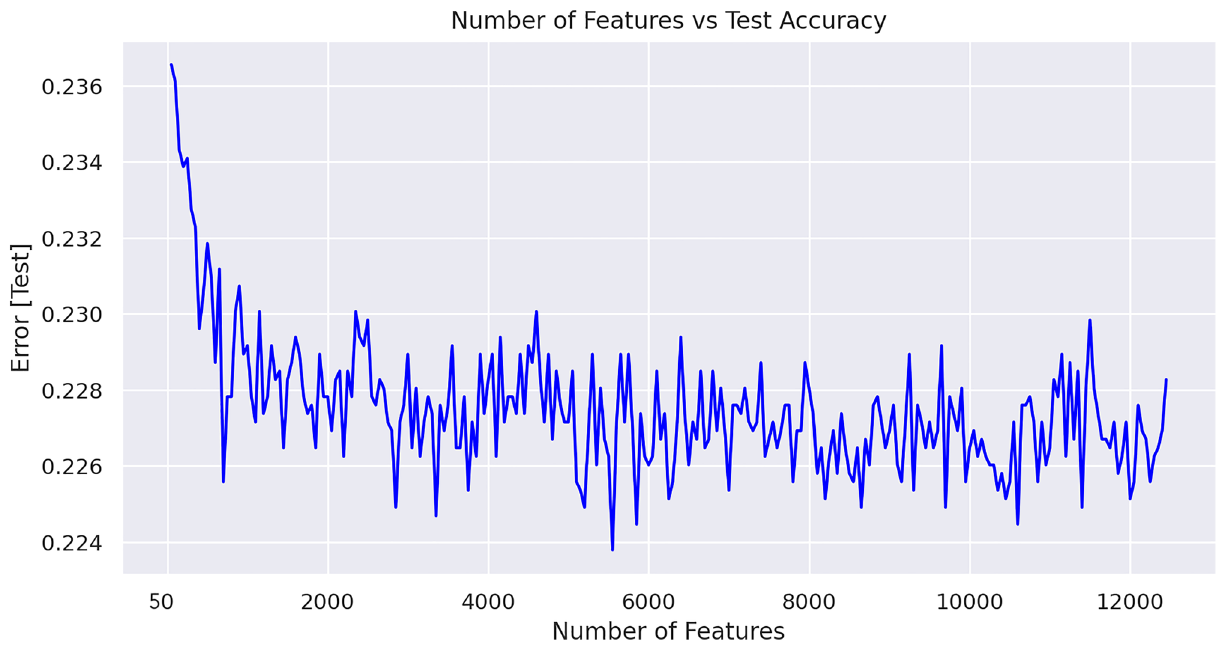
Figure 4. Number of features used for model training vs test error for xgBoost model trained on Phase 2 studies dataset. This plot is used for defining the feature set size by using the elbow point where the decrease angle of the error line dropped significantly, so that we know adding more features does not have a significant effect on the performance.